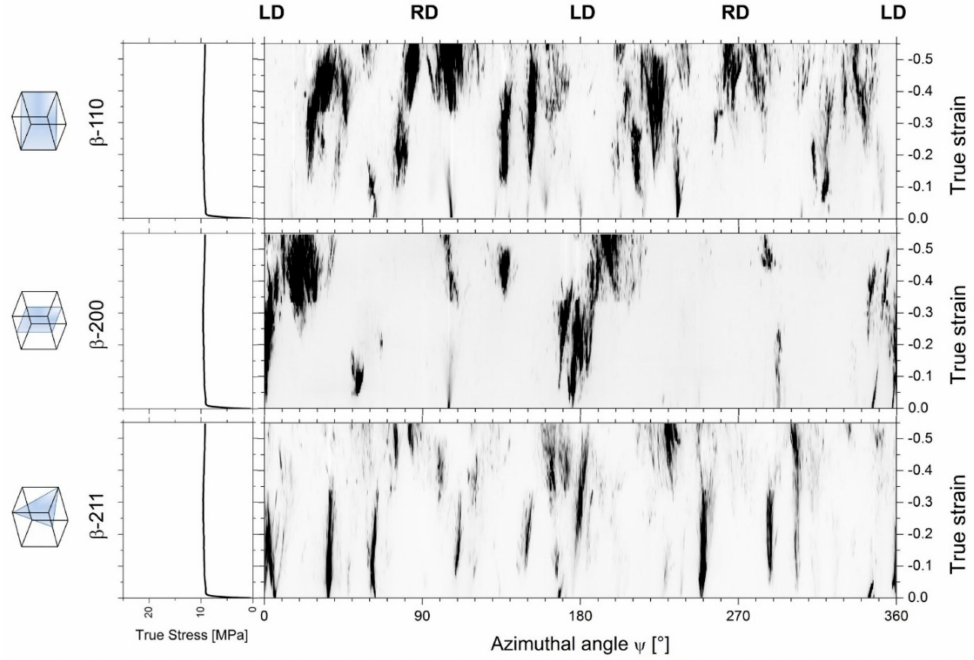
Figure 4. AS-plots under compression at 0.001 s − 1 at 1030 ◦ C for the ( a ) β -110, ( b ) β -200, and ( c ) β -211 crystallographic planes. The flow curves are plotted on the left, while at the bottom ψ is indicated. LD and RD correspond to the load and radial directions,